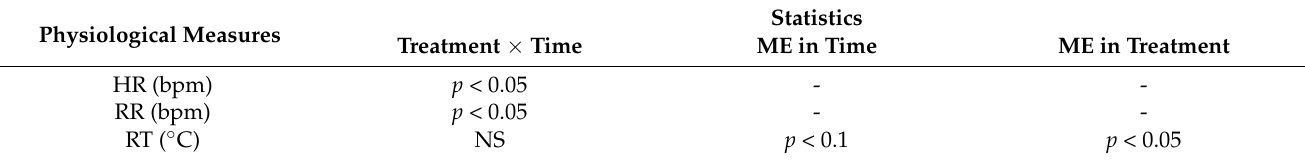
Table 7. Statistics 1 of heart rate (HR), respiratory rate (RR), and rectal temperature (RT).